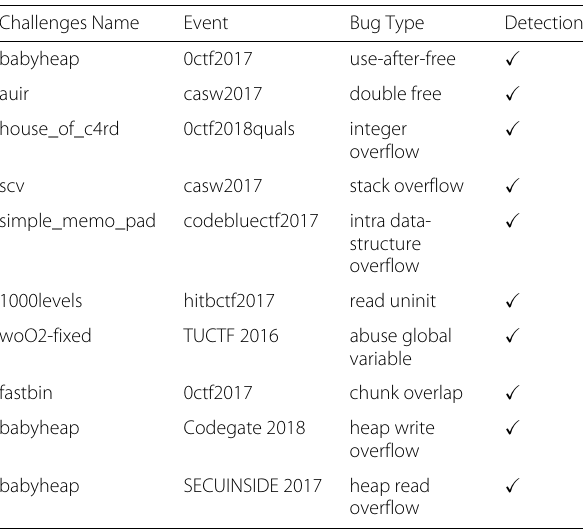
Table 3 The detection result of MAI on CTF challenges with ten different memory corruption